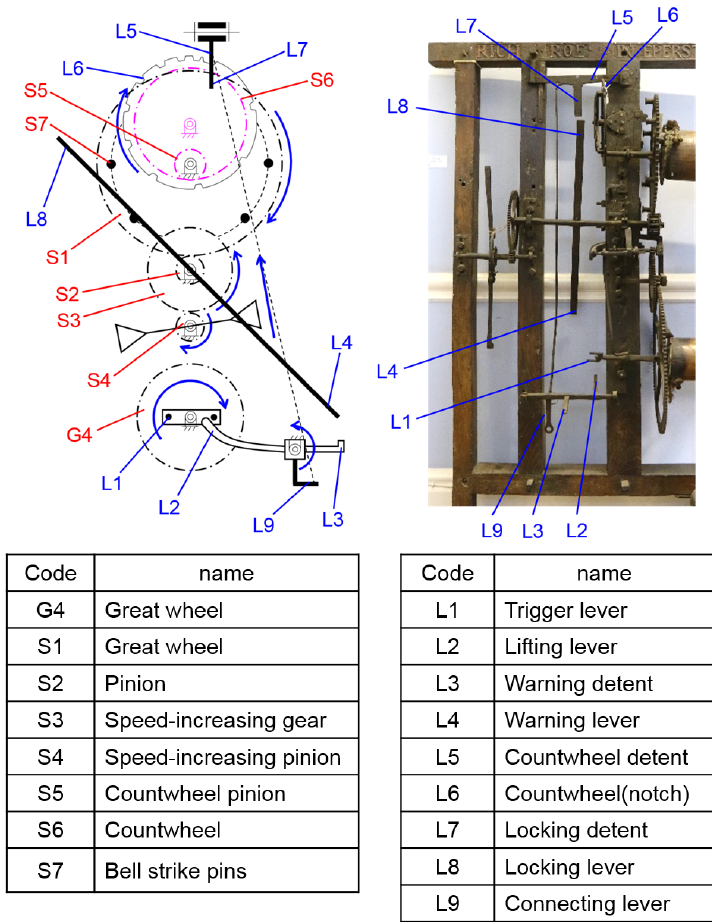
Figure 13. Striking train structure of the Plumtree clock (N9) (Rabbott, 2018).